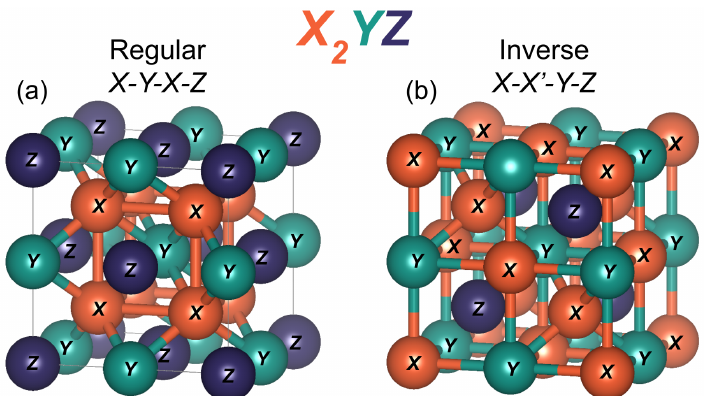
Figure 7. Crystal structure of the full-Heusler X 2 YZ alloys with ( a ) the regular Cu 2 MnAl-type and ( b ) the inverse Hg 2